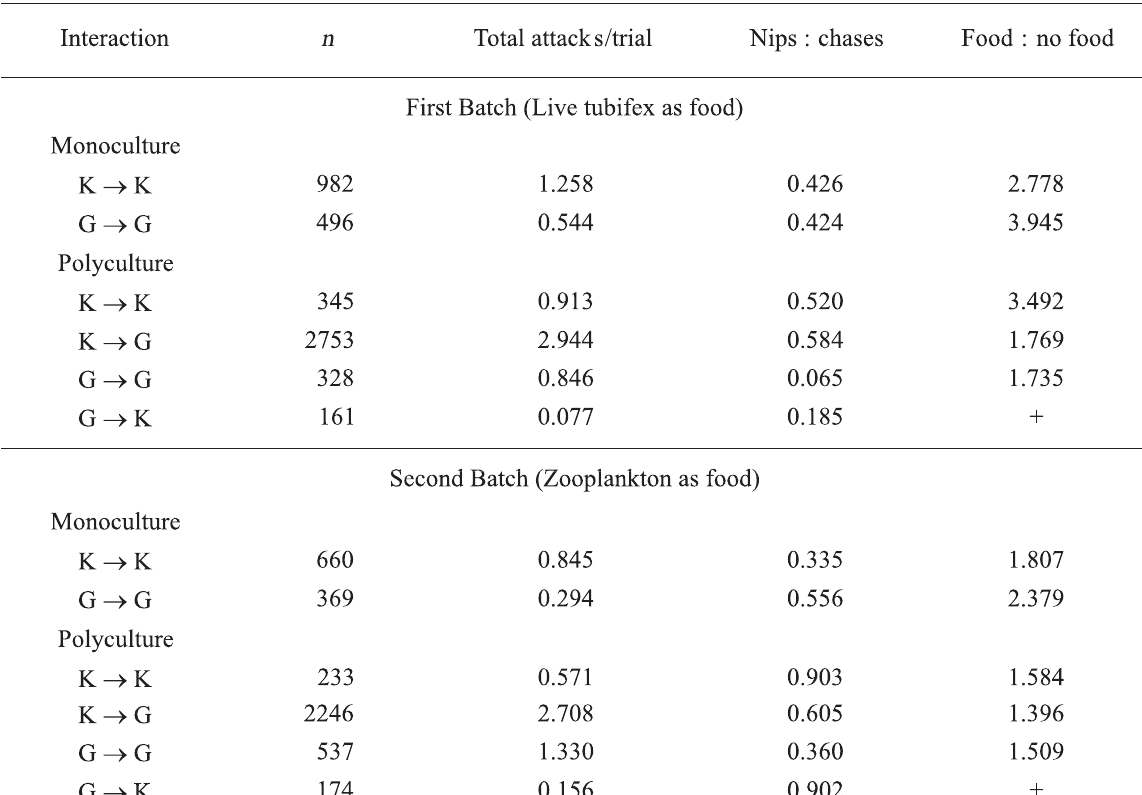
Standardised frequency of attacks calculated for koi carp (K) and goldfish (G) in the two experimental